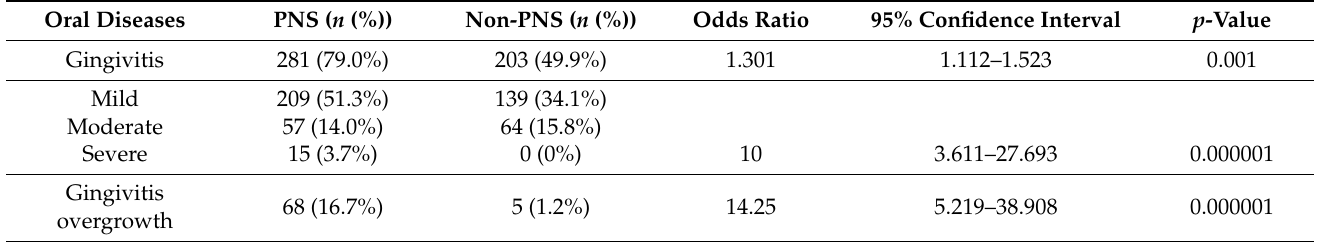
Table 2. The percentage of oral diseases in PNS and non-PNS